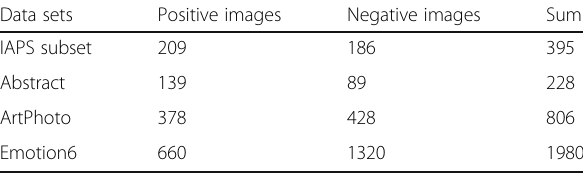
Data sets Positive